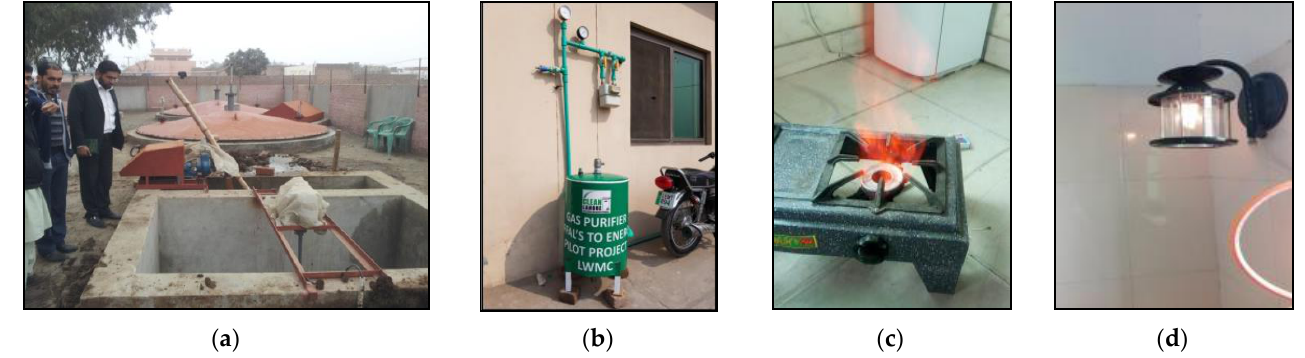
Figure 15. Waste-to-biogas projects in city: ( a ) Biogas project at Ichu-Gill village; ( b ) Gas purifier installed at disposal facility; ( c ) Utilization of landfill biogas in kitchen; ( d ) Utilization of biogas for lighting the administration building at disposal facility.